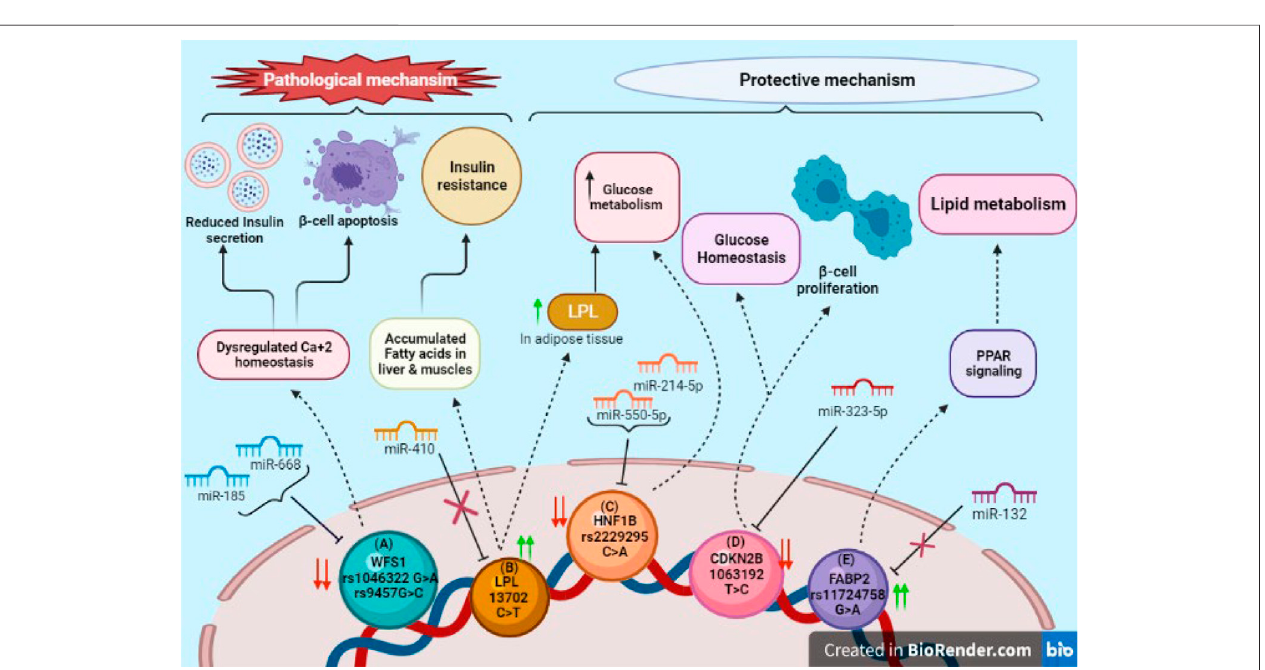
FIGURE 4 | SNPs in 3 ′ UTR of target genes associated with diabetes: (A) Downregulation of WFS1 due to SNPs rs1046322 (G > A) and rs9457 (G > C) via miRNAs miR185andmiR668induces β -cellapoptosisanddeclinesinsulinsecretionduetoERCa +2 stress. (B) SNPrs13702(C > T)inLPLgenedisruptsbindingsiteformiR410. Its overexpression has pathological impact on liver and muscles leading to insulin resistance; whereas in adipose tissue it increases glucose metabolism. (C) SNP rs2229295 (C > A) of HNF1B creates new binding site for miR214-5p and miR550-5p, increasing glucose metabolism. (D) CDKN2B ’ s downregulation due to